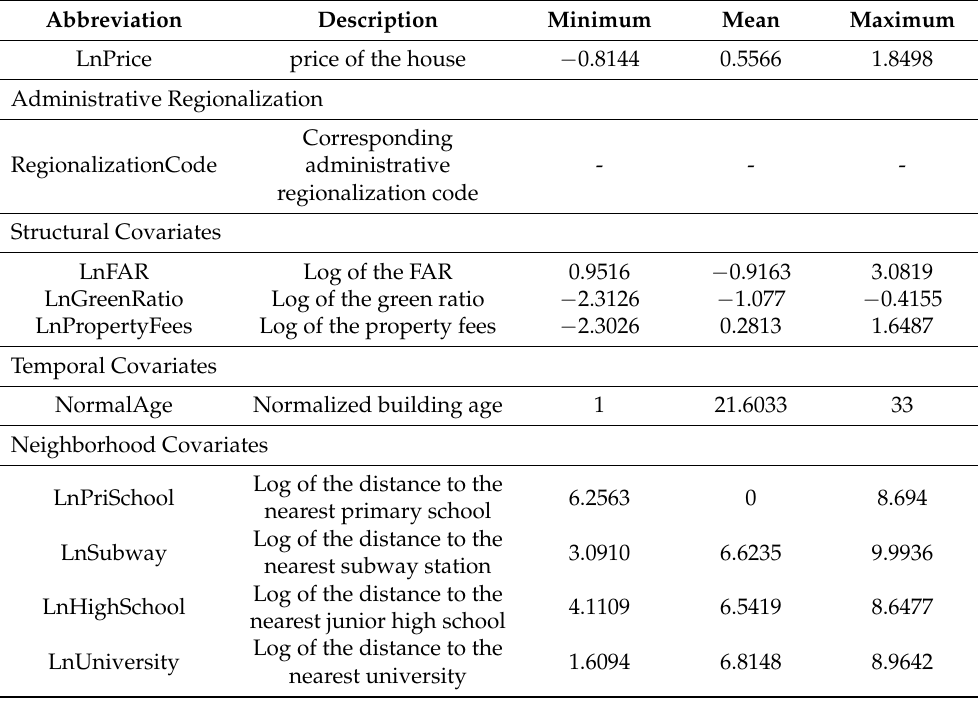
Table 2. Variables used to predict housing prices in Wuhan, Hubei,